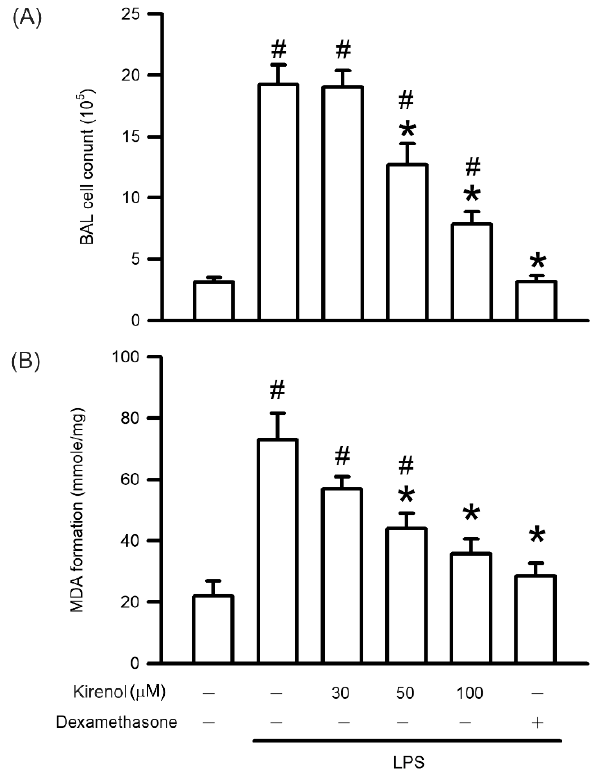
Figure 3. Kirenol protected against leukocyte infiltration and lipid peroxidation. ( A ) Leukocytes infiltration was determined by cell counter assay activity in BALF. ( B ) Lipid peroxidation was determined by thiobarbituric acid (TBA) reactive substance assay in the lungs. Values are shown the mean ± S.D. of 3–4 mice per group. # represents the significant difference compared with the Group I ( p < 0.05); * represents the significant difference compared with the Group II ( p < 0.05).